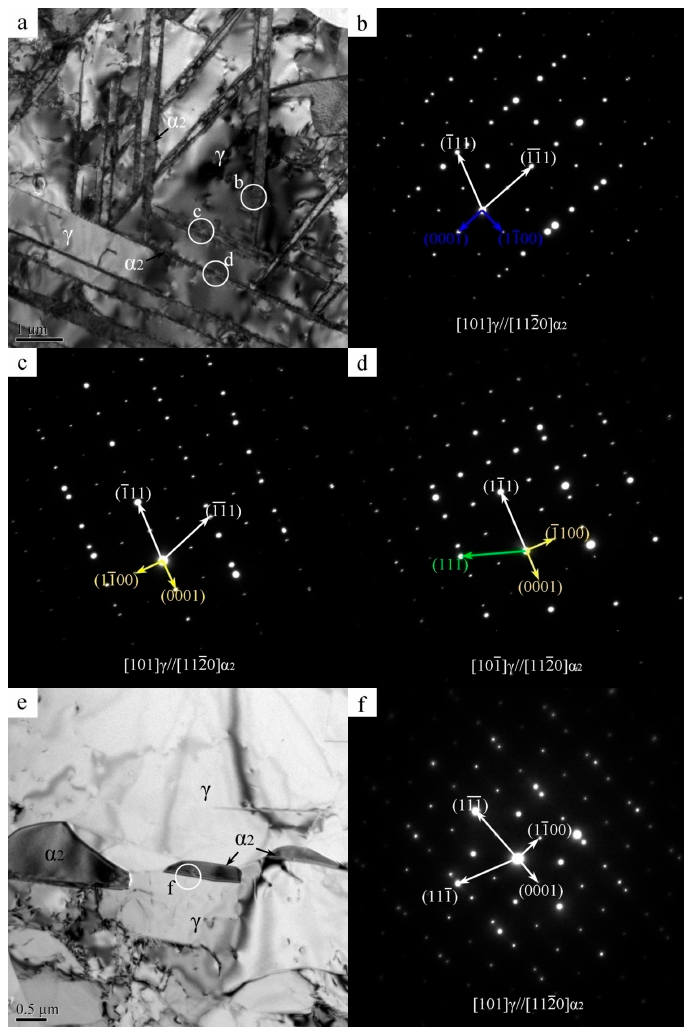
Figure 6. ( a ) TEM image of the precipitated α 2 laths in the massive transformed γ phase; different variants are observed growing along various {111} γ planes; ( b – d ) SAD patterns of the corresponding circled areas in ( a ), indicating the α 2 variants following the Blackburn orientation relationship and the twinning of the γ phase; ( e , f ) TEM image and the corresponding SAD pattern of the globular α 2 grains formed at the boundary of the γ phase; the α 2 grains tend to form the Blackburn orientation relationship with one side of the γ phase.